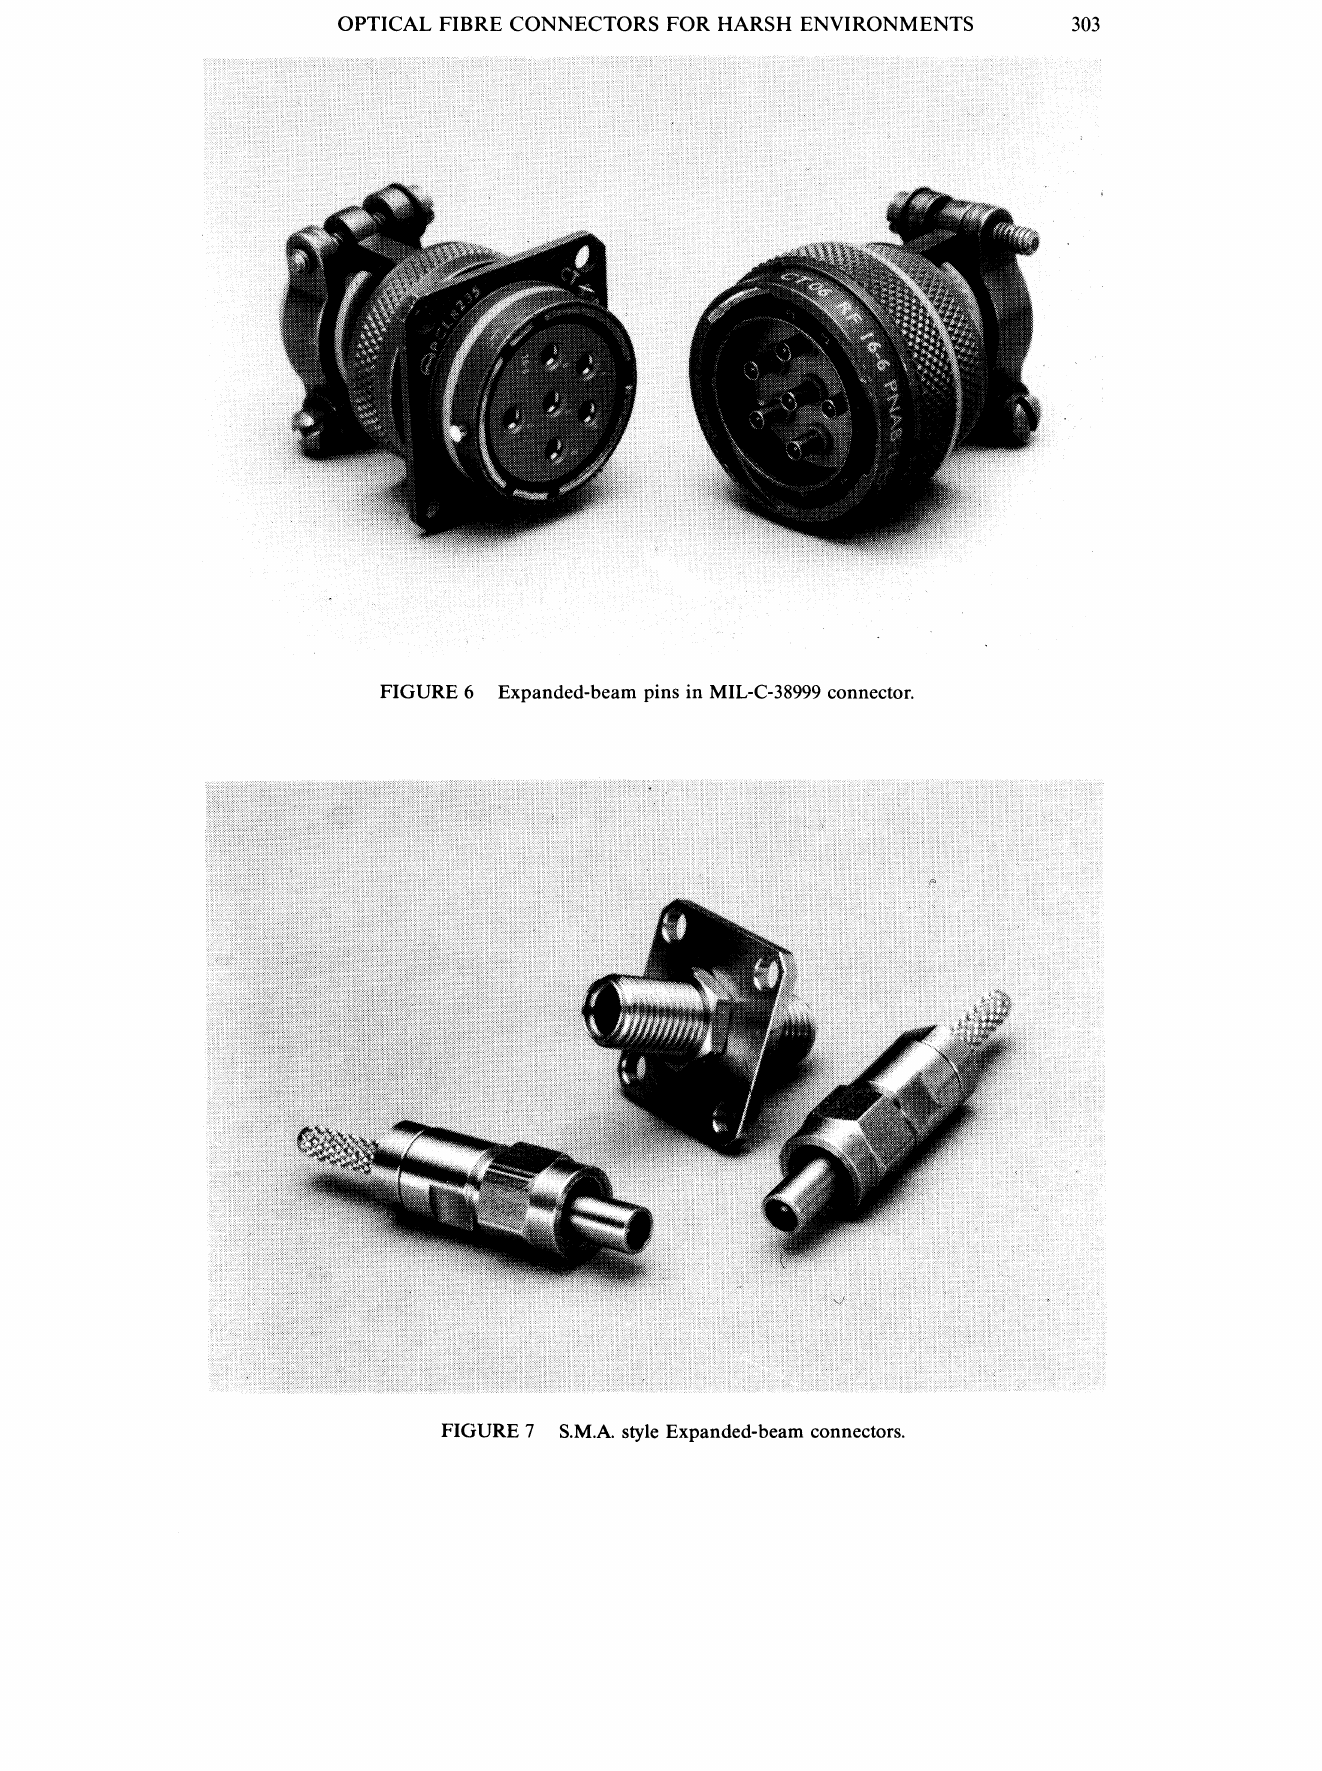
FIGURE 7 S.M.A. style Expanded-beam